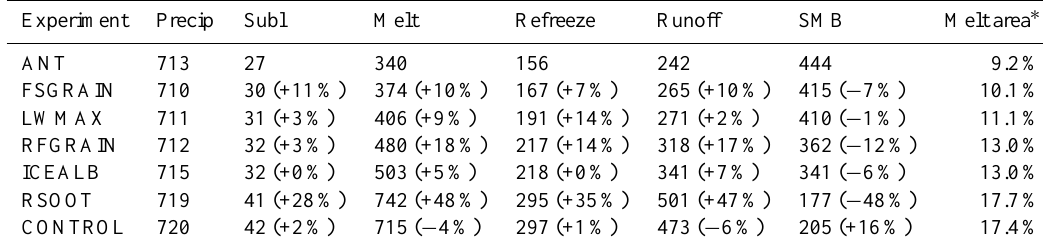
Table 2. SMB components for different model runs, year 2007. Relative changes in parentheses.